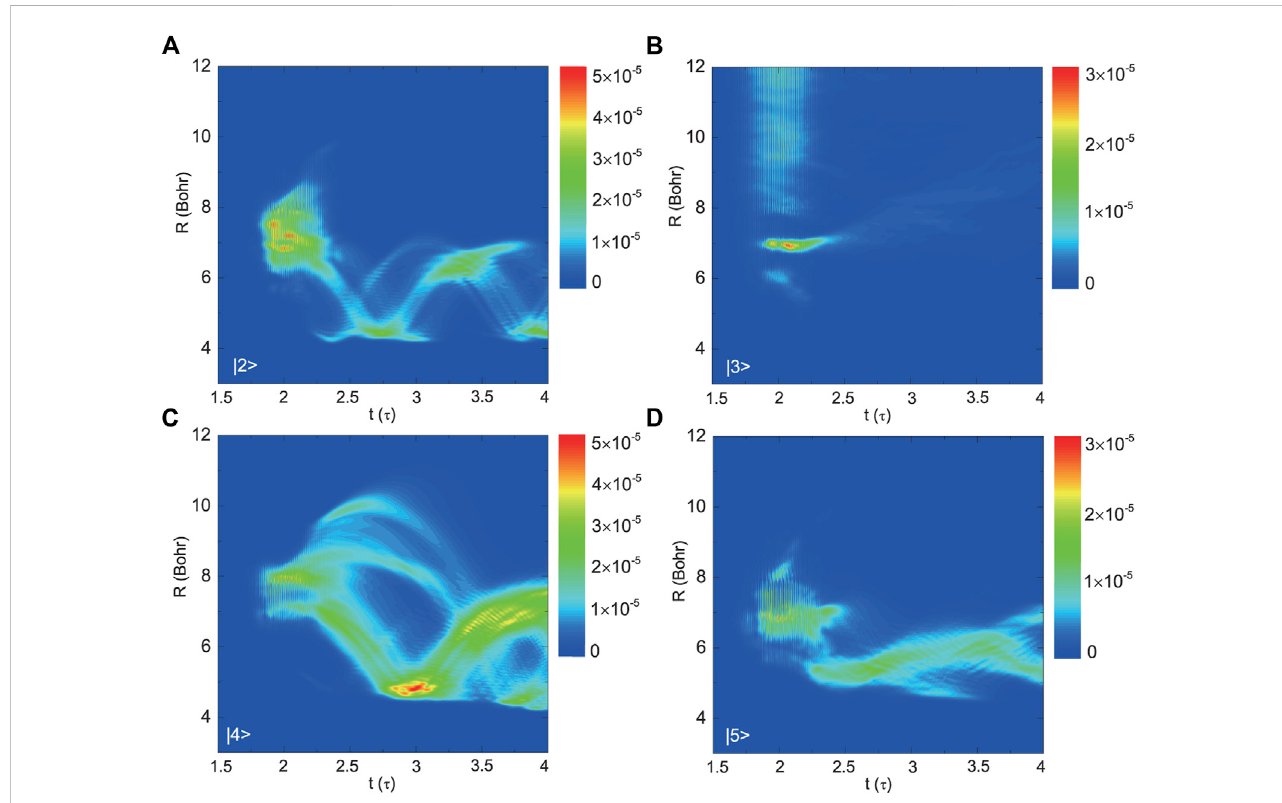
FIGURE 6 The propagations of the radial wavepackets for the four excited states, (A) |2 〉 , (B) |3 〉 , (C) |4 〉 , and (D) |5 〉 , in Case 1 with τ = 50 fs and δ t 0 = 0.